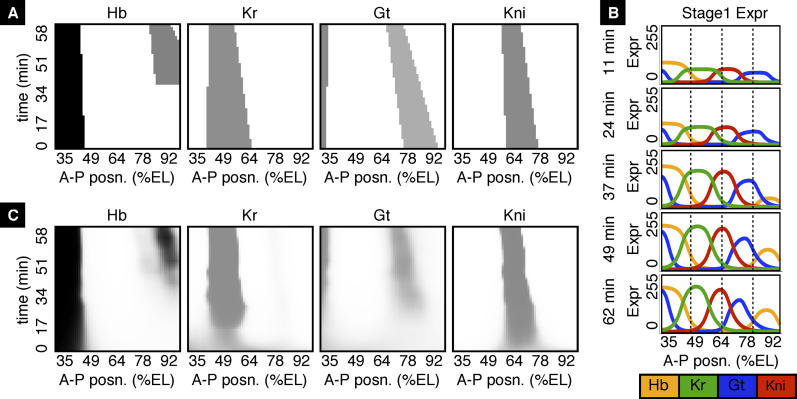
Outline of the Optimization ApproachIn Stage 1, protein production associated to each domain is assumed to fall within a quadrilateral-shaped region of space–time (A) (darkness indicates rate of production), whose boundaries are optimized so that simulated expression (B) matches observed data (Figure 3B).In Stage 2, regulatory parameters are estimated by trying to fit the quadrilateral production regions (A) based on the observed levels of transcription factors present at each space–time point (C).In Stage 3, local search, starting from the parameter values estimated in Stage 2, is used to optimize a fully coupled partial differential equation model of gene expression, so that simulated expression (Figure 3C–3F) matches observed expression (Figure 3B).